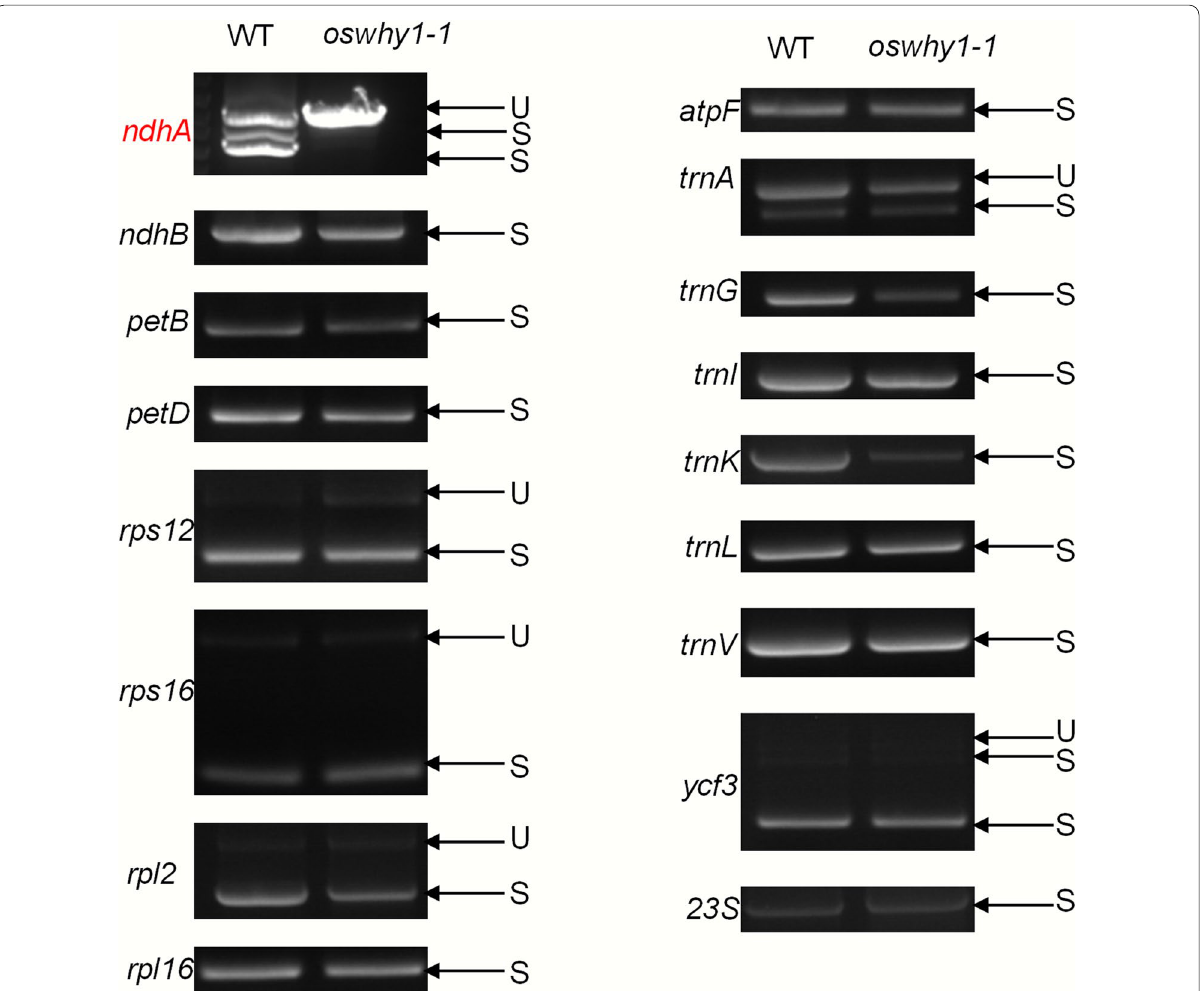
Fig. 5 Splicing analysis of rice chloroplast genes in the WT and oswhy1-1 leaves. U indicates unspliced transcripts; S indicates spliced